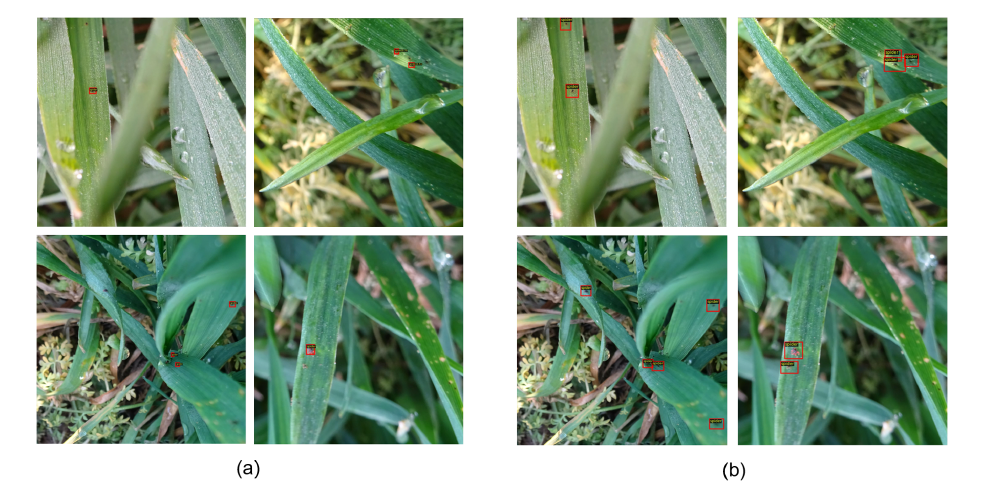
Figure 10. Comparison of detection effects: ( a ) detection of the RetinaNet; ( b ) detection of our improved